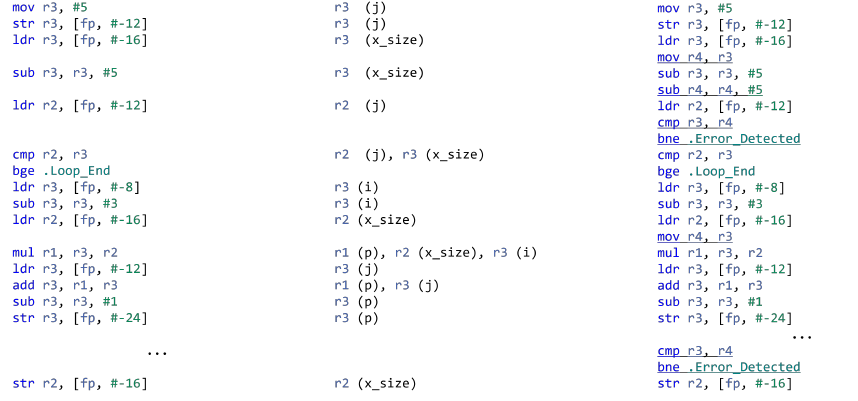
Figure 3. Our low-level protection schemes to protect critical variables.